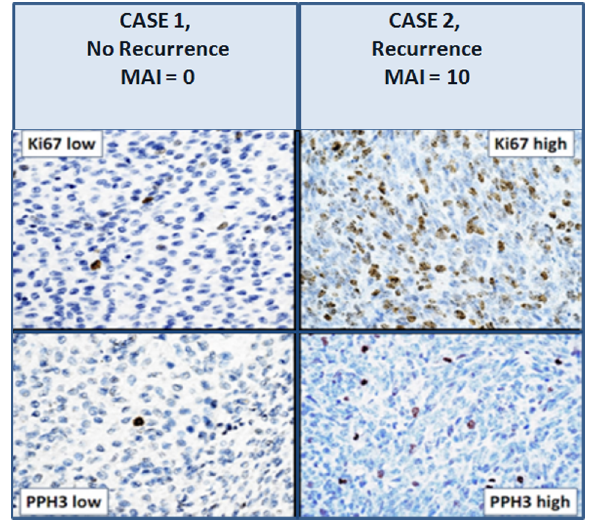
Figure 2. Examples of Endometrial Stroma Sarcomas showing parallel Ki-67 and PPH3 expression. A, B: Low Ki-67 and PPH3 expression in the same case. C, D: High expression of Ki-67 and PPH3 in the another